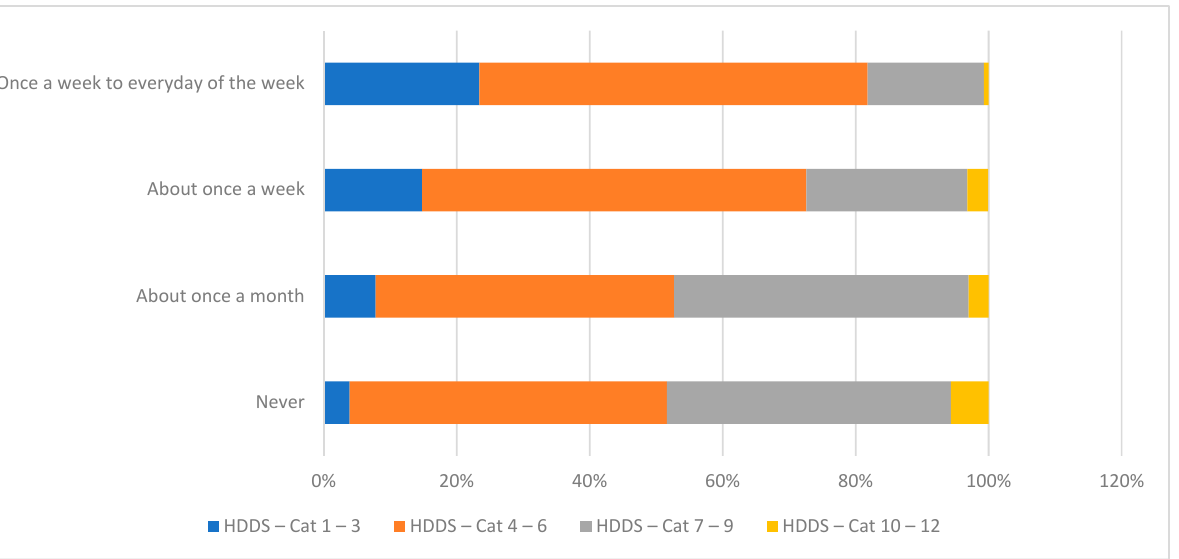
Figure 2. Dietary diversity and frequency of food price increases. Notes: HDDS = Household Dietary Diversity Score; Cat = Category.